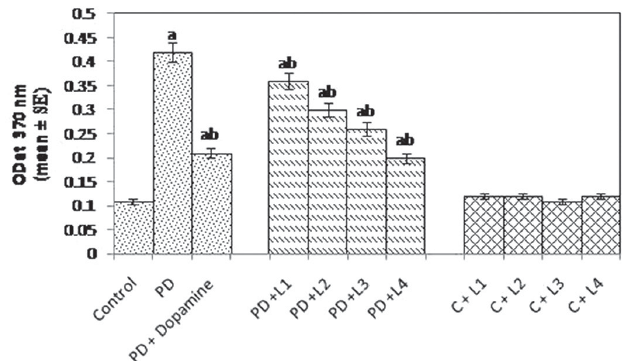
FIGURE 7 - Effect of luteolin on caspase-3 activity in the brains of flies. [L1= 25 µM; L2= 50 µM; L3 = 75 µM; L4= 100 µM; PD = PD flies; Dopamine=10-3 M]. The flies were allowed to feed on the diet supplemented with luteolin for 24 days and then assayed for caspase-3 activity. The values are the mean of 5 assays. [a - significant at p<0.05 compared to control; b - significant at p<0.05 compared to PD flies].